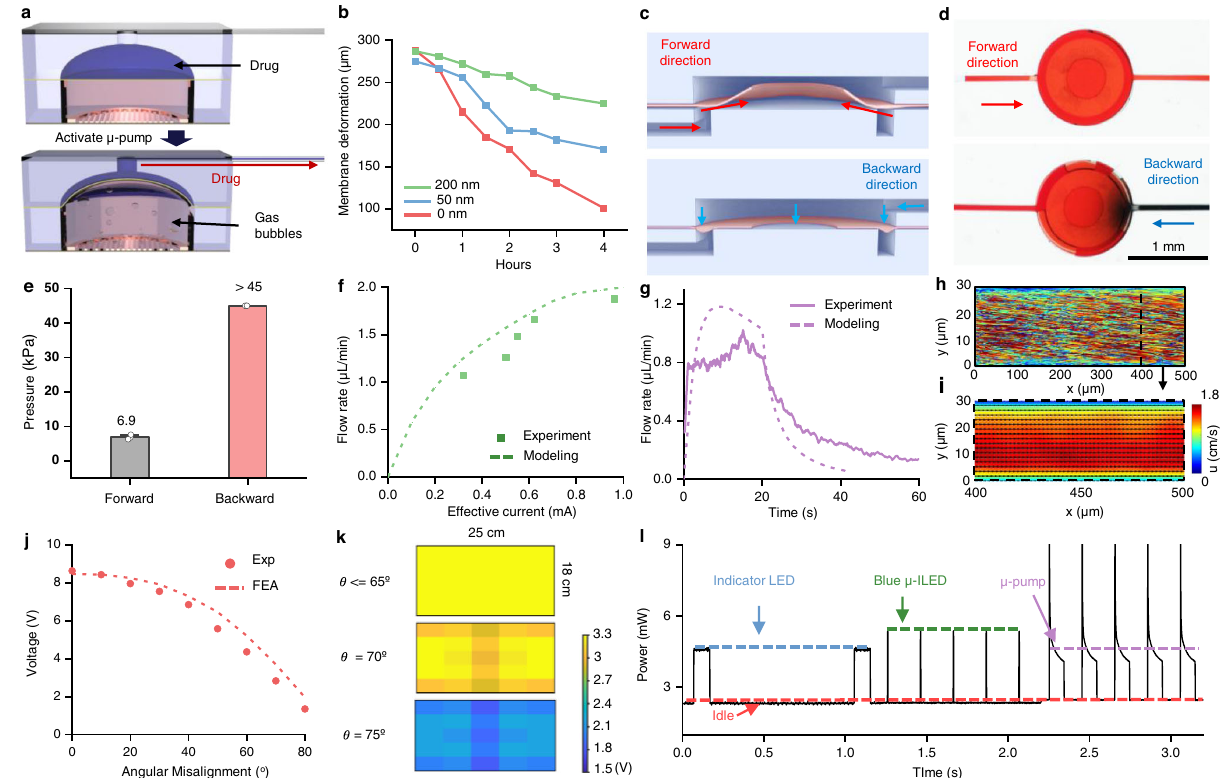
Fig. 3 | Fluidic and electronic characteristics of multi-model wireless opto- fl uidic system. a Schematic diagram of the electrochemical µ -pump actuated by electrolysis reaction. b Relaxation of the fi lm with different thicknesses of gold coatings (0/50/200nm) following actuation after 2min of µ -pump activation. c , d Schematic illustrationsand photographsofthe passive fl appervalve with fl ow from forward and backward directions. In the photos, the red aqueous solution fl owsthrough thevalvefromthe forwarddirectionwithlow resistance,whileeven under high pumping pressure, the blue aqueous solution is unable to pass. The bluecolorisfromthebluedyediffusioninthetoplayer. e Burstpressurerequired for fl ow through the passive fl apper valve from the forward and backward direc- tions. n =3.Dataarepresentedasmeanvalues±SEM.Backwarddirectionpressure data from three independent samples exceed the upper limit of the instrument